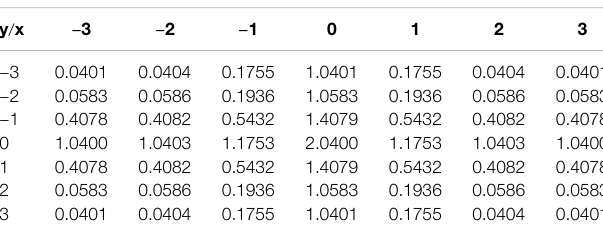
TABLE 5 | Positive surface data from function F 3 ( x , y )